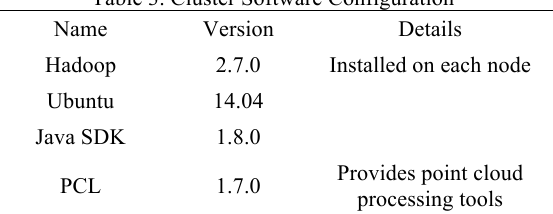
Table 3. Cluster Software Configuration